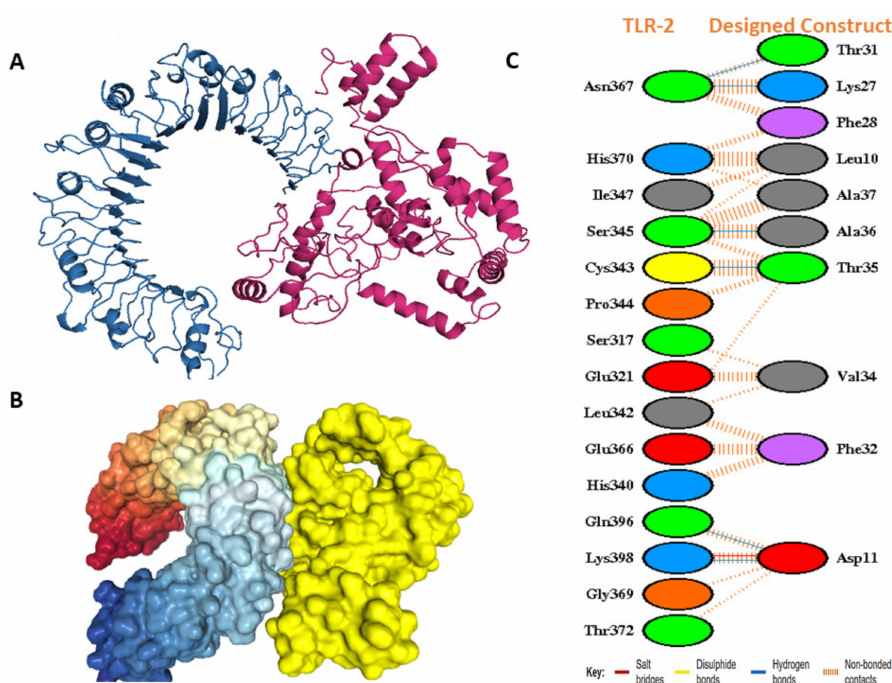
Figure 8. Docking studies of the designed molecule with TLR 2. ( A ) ClusPro-generated docked complex. The blue ribbons symbolize the TLR 2 molecule, while the warm pink corresponds to the vaccine molecule. ( B ) HDOCK docked complex (yellow represents vaccine). ( C ) Residue interactions between TLR 2 and vaccine construct. Hydrogen bonds are revealed with blue